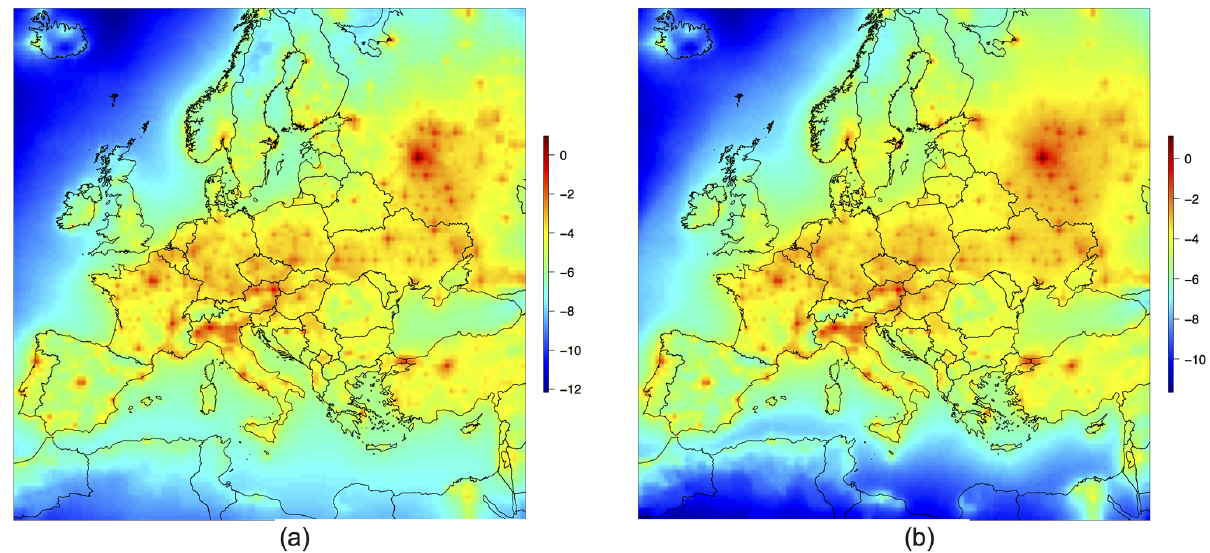
Figure 2. Annual average surface-level BaP concentrations [log c BaP (ngm − 3 )] during 2006 plotted in logarithmic scale for (a) the Junge– Pankow (JP) scenario 1 and (b) for the fully expanded GPP scenario 5, which includes a heterogeneous reaction with